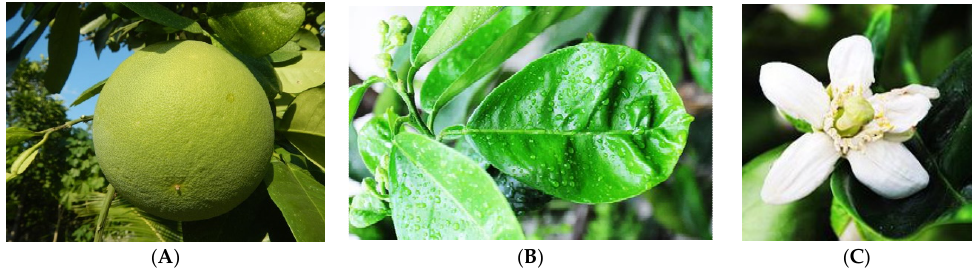
Figure 2. The ( A ) fruit; ( B ) leaf; and ( C ) flower of C. grandis . (Photos kredit: Judgefloro, Davidals, Amada44)